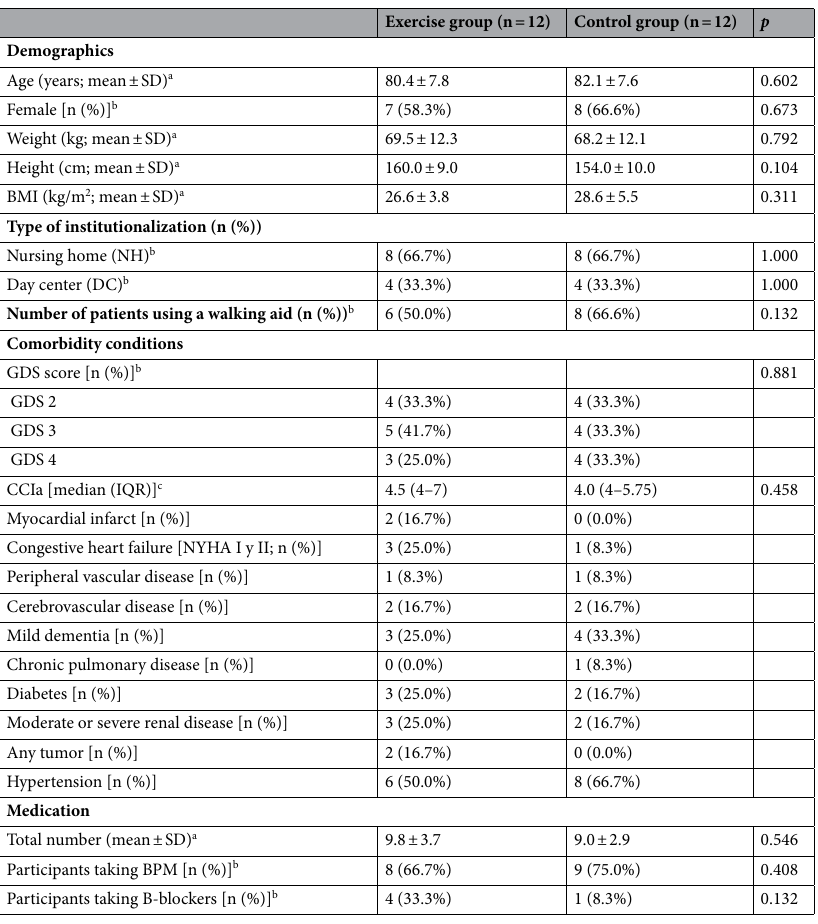
Table 1. Demographic and health characteristics of the participants. BMI body mass index, BPM medications that lower or potentially lower blood pressure, CCIa Charlson comorbidity index adjusted by age, GDS global deterioration scale, IQR interquartile range. a t -test, b Chi-squared test, c Mann–Whitney U